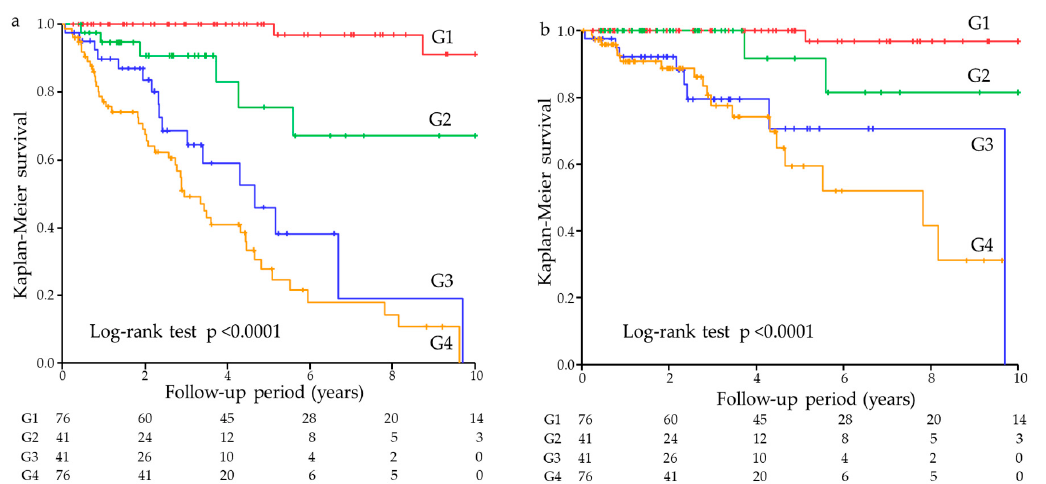
Figure 1. Kaplan–Meier survival curves for all-cause and cardiovascular mortality. ( a ) All-cause mortality among the four groups divided by the median GNRI and ECF/ICF ratio. ( b ) Cardiovascular mortality among the four groups divided by the median GNRI and ECF/ICF ratio. Abbreviations: GNRI, geriatric nutritional risk index; ECF, extracellular fluid; ICF, intracellular fluid; G1, higher GNRI and lower ECF/ICF; G2, lower GNRI and lower ECF/ICF; G3, higher GNRI and higher ECF/ICF; G4, lower GNRI and higher ECF/ICF.